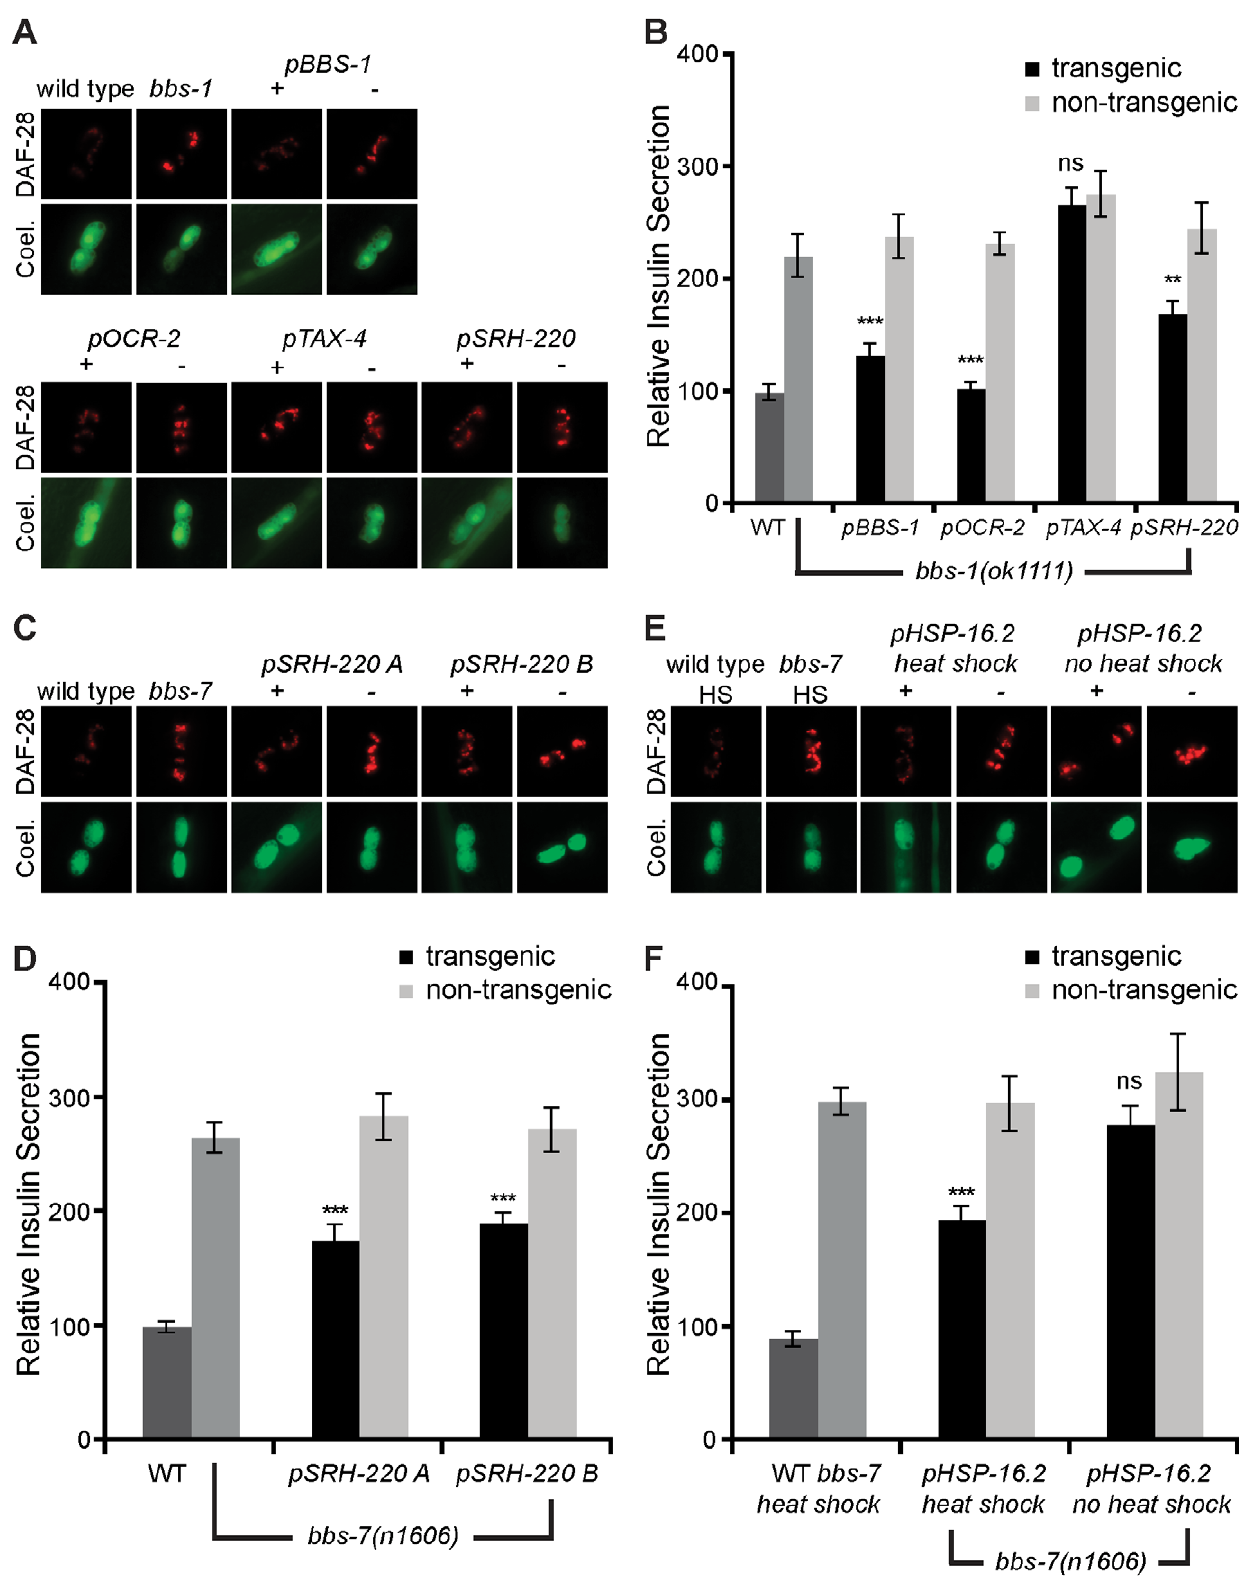
Figure 3. BBSome regulate secretion partially cell autonomously. (A, C, E) Representative images of tagged insulin accumulation in coelomocytes, and (B, D, F) corresponding quantitation with standard error (*** p , 0.001, ** p , 0.01; ns, not significant, comparing transgenic to non- transgenic siblings). (A, B) Transgenic ( + ) and non-transgenic siblings ( 2 ) expressing bbs-1 cDNA under the indicated promoters. Expression patterns of these promoters are listed in Table S1. Transgenic ( + ) and non-transgenic siblings ( 2 ) expressing bbs-7 cDNA exclusively in ADL using the srh-220 promoter (C, D) or the heat shock inducible, hsp-16.2 , promoter (E, F). doi:10.1371/journal.pbio.1001219.g003 PLoS Biology |